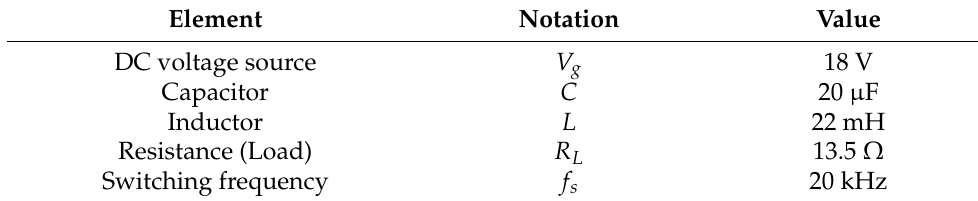
Table 1. Values for the parameters of the boost converter shown in Figure 1.